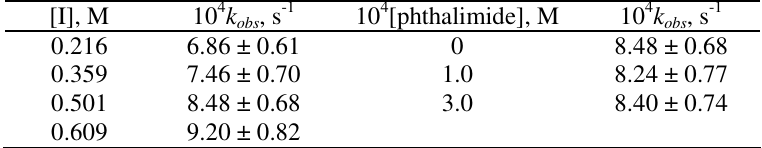
Table 2. Influence of ionic strength and phthalimide on reaction rate for the oxidation of PTAA with NBP at 298 K